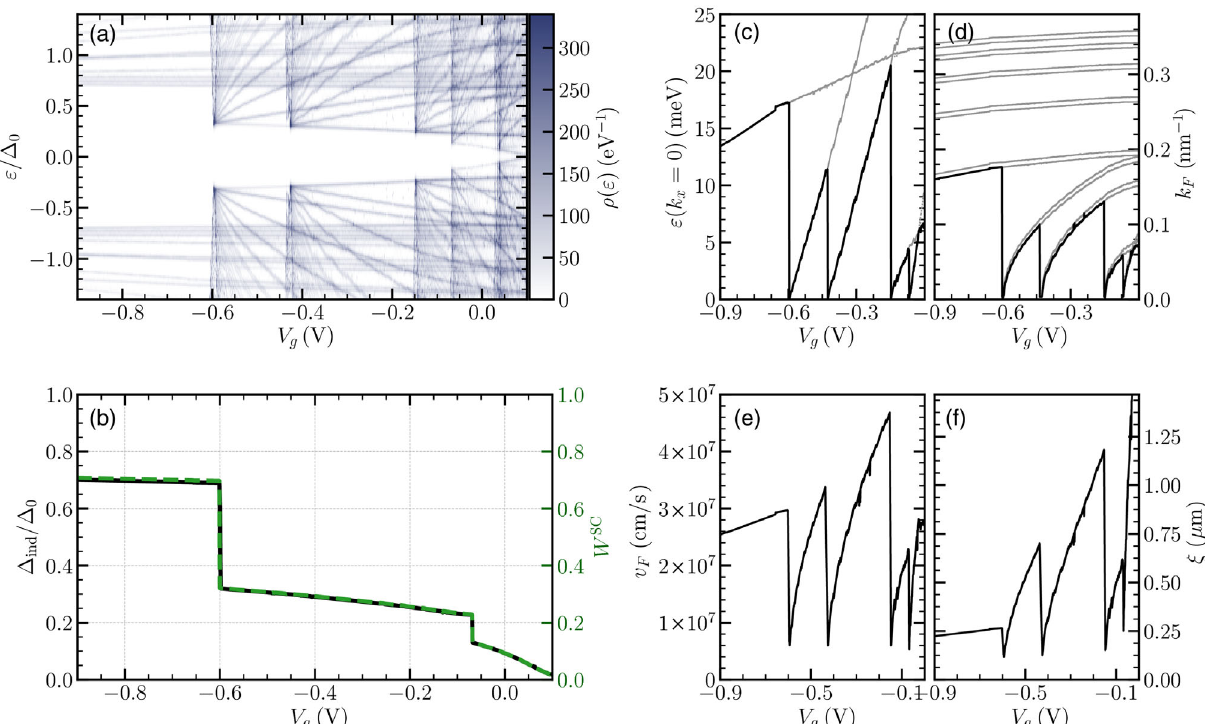
FIG. 7. Characterization of the superconducting state at B ¼ 0 , i.e., in the trivial s -wave superconducting phase, as a function of the gate voltage V . (a) Density of states, (b) induced gap (black) and weight in the superconductor (green), (c) Fermi energy, (d) Fermi g momentum, (e) Fermi velocity, and (f) SC coherence length. The discontinuities correspond to transitions where bands are driven below the chemical potential and thus become occupied [for an illustration, consider the transition between Figs. 8(a) and 8(c)]. In panel (b), the correspondence between the magnitude of the induced gap and the hybridization between SM and SC (as measured by the W SC ) is clearly shown. In panels (c) and (d), all bands are shown in gray, while the occupied band closest to the Fermi energy is highlighted in